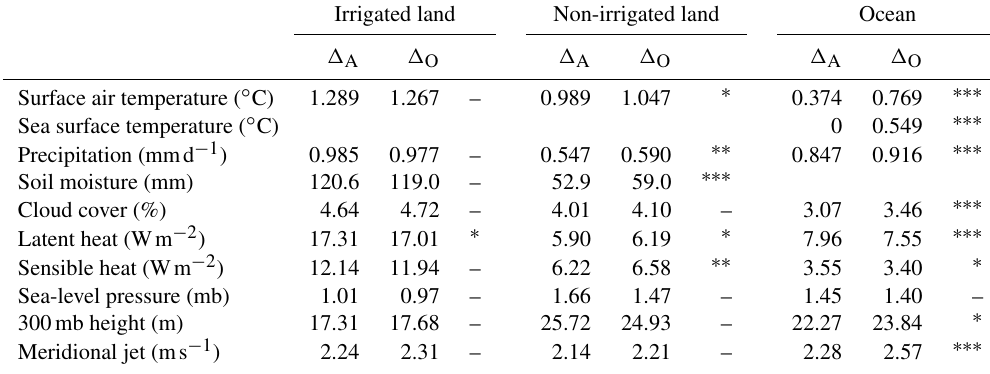
Table 3. Root mean square impact of irrigation on time-mean climate quantities with and without interactive sea surface temperatures. Irrigated